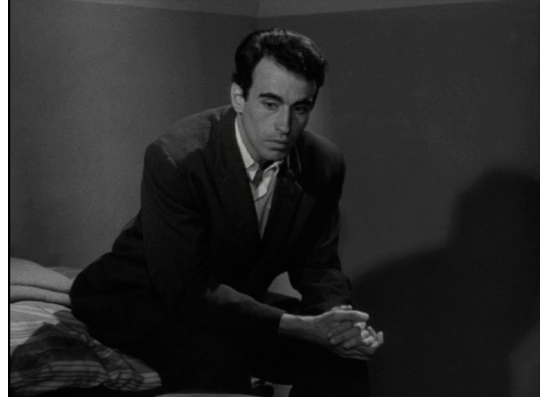
Figure 3. Why live? Source Artificial Eye: ART 295 DVD.